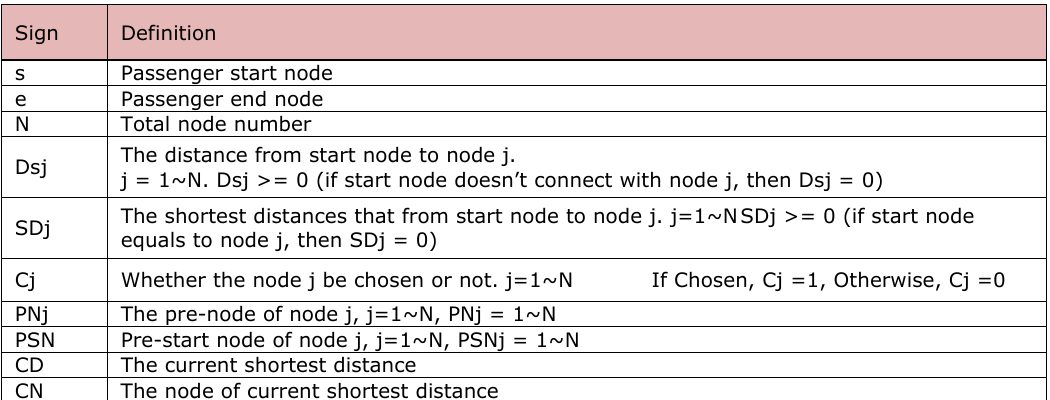
Table 2. “The signs and their definition of Dijkstra’s